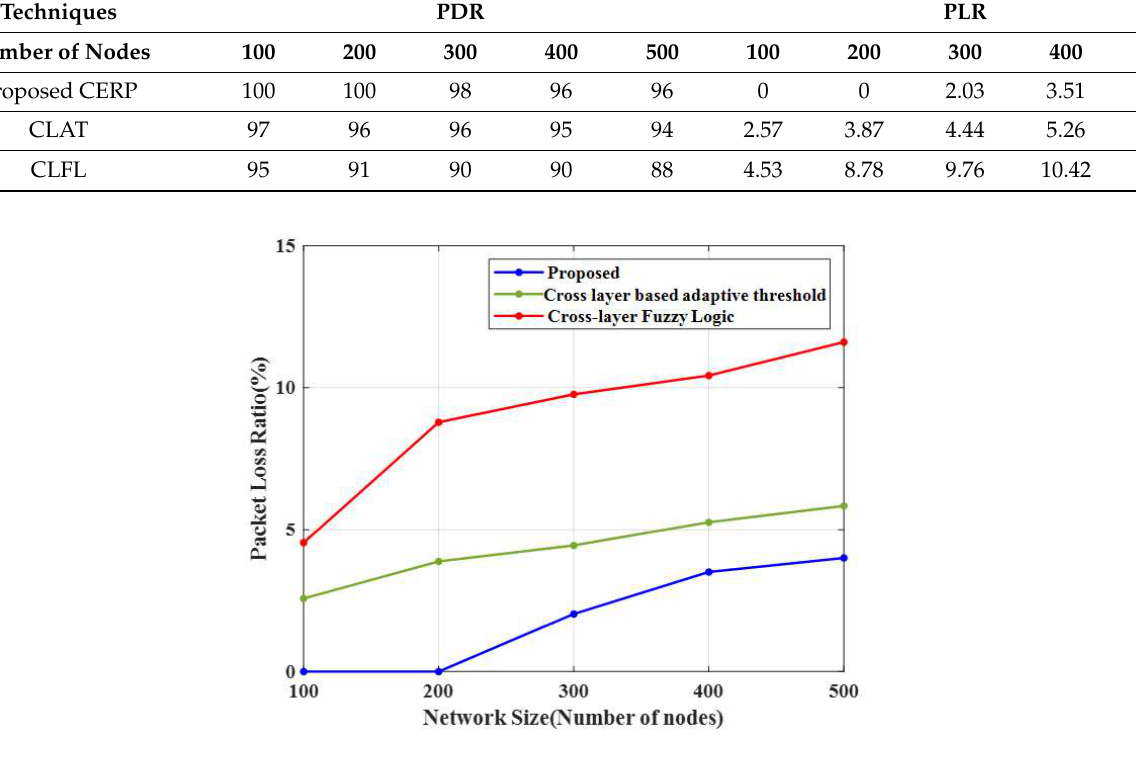
Figure 10. Comparison of the packet loss ratio. Table 6. Comparison of PDR and